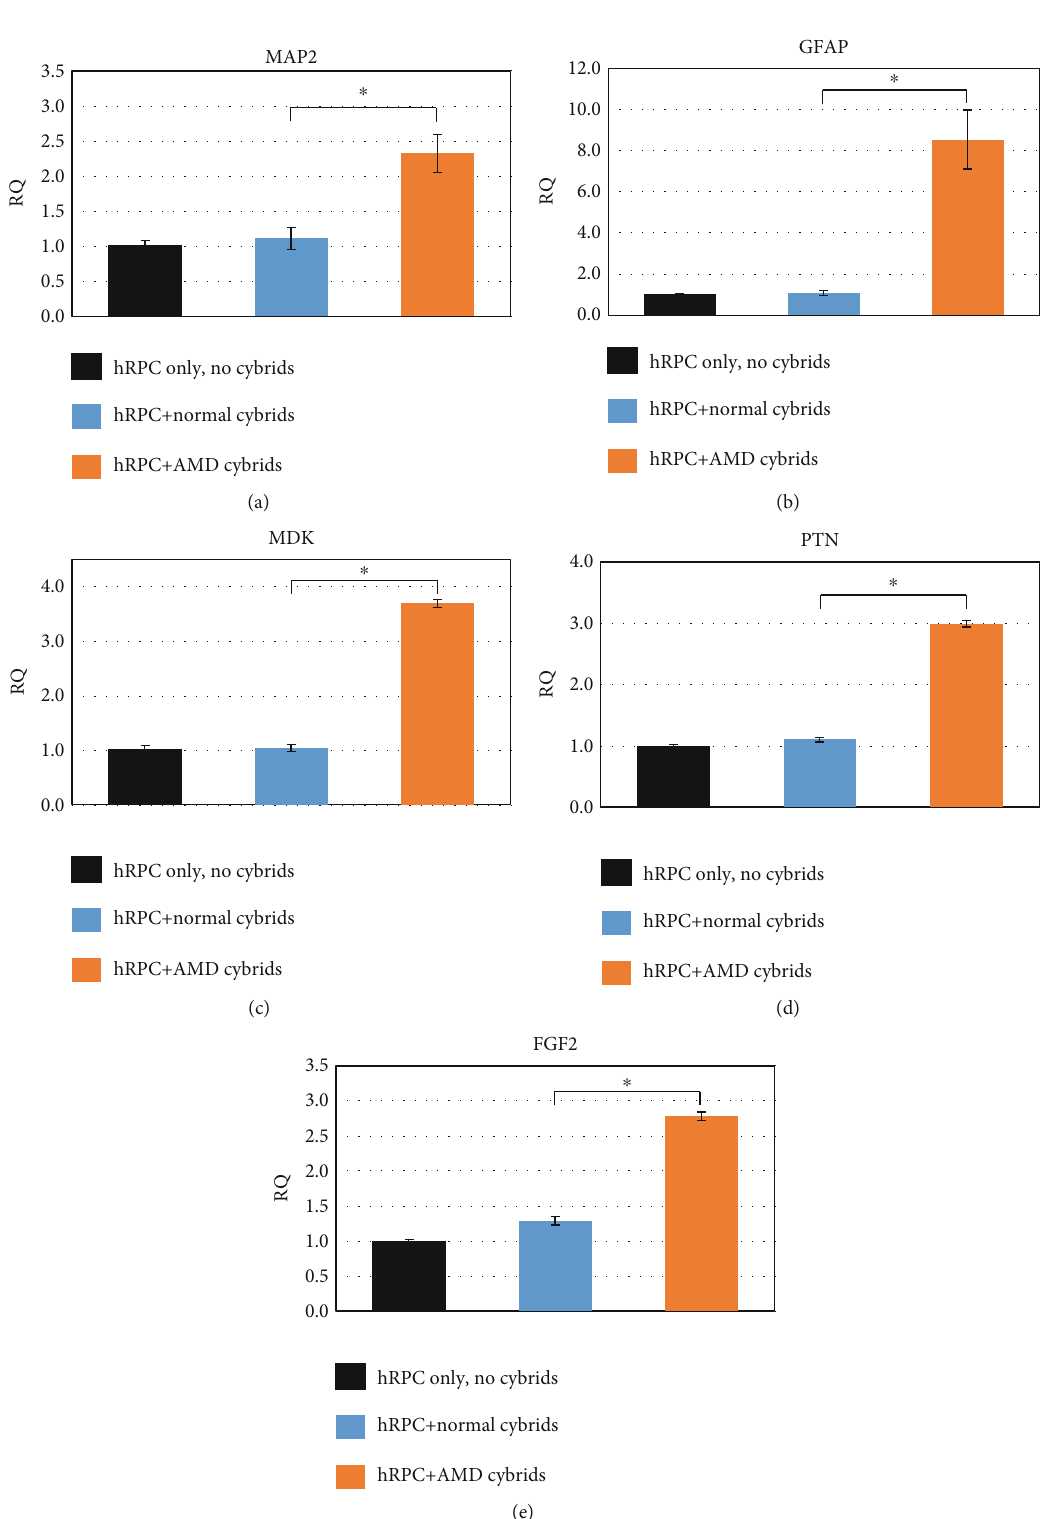
Figure 5: Increased expression of neuronal/glial lineage and neuroprotective genes in hRPCs after coculture with AMD cybrids. In hRPCs, coculture with AMD cybrids signi fi cantly increased the expression of (a) markers of neuronal ( MAP2 , foldchange = 2 : 08 , p < 0 : 01 ) and (b) glial lineage ( GFAP , foldchange = 7 : 93 , p < 0 : 01 ) and neuroprotective factors (c) MDK ( foldchange = 3 : 53 , p < 0 : 01 ), (d) PTN ( fold change = 2 : 71 , p < 0 : 01 ), and (e) FGF2 ( foldchange = 2 : 16 , p < 0 : 01 ) compared to hRPCs with age-matched normal cybrids. The relative quanti fi cation ( RQ = 2 − ΔΔ Ct ) was utilized for the data, and Tukey t -test and Student t -test (unpaired) were used for p values between the two groups, with signi fi cance determined at p < 0 : 05 . See Table